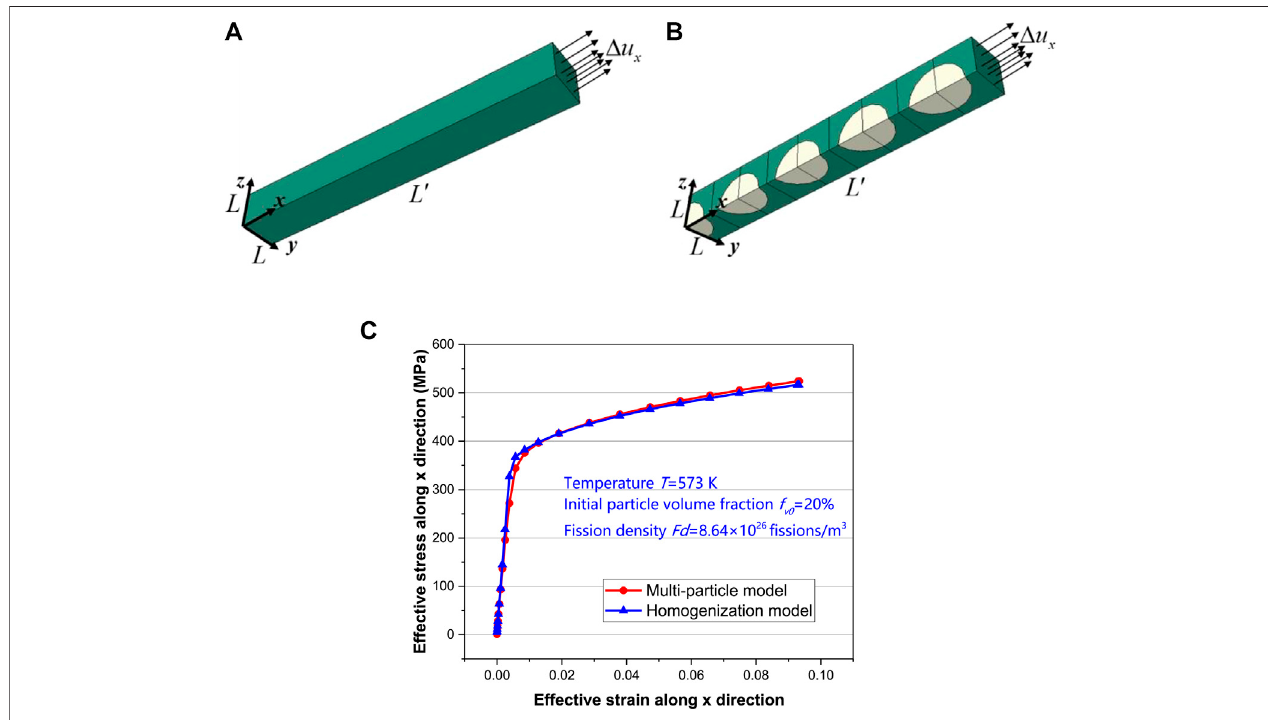
FIGURE 2 | (A) Homogenization model, (B) a multiparticle model, and (C) veri fi cation of the effective elastoplastic constitutive